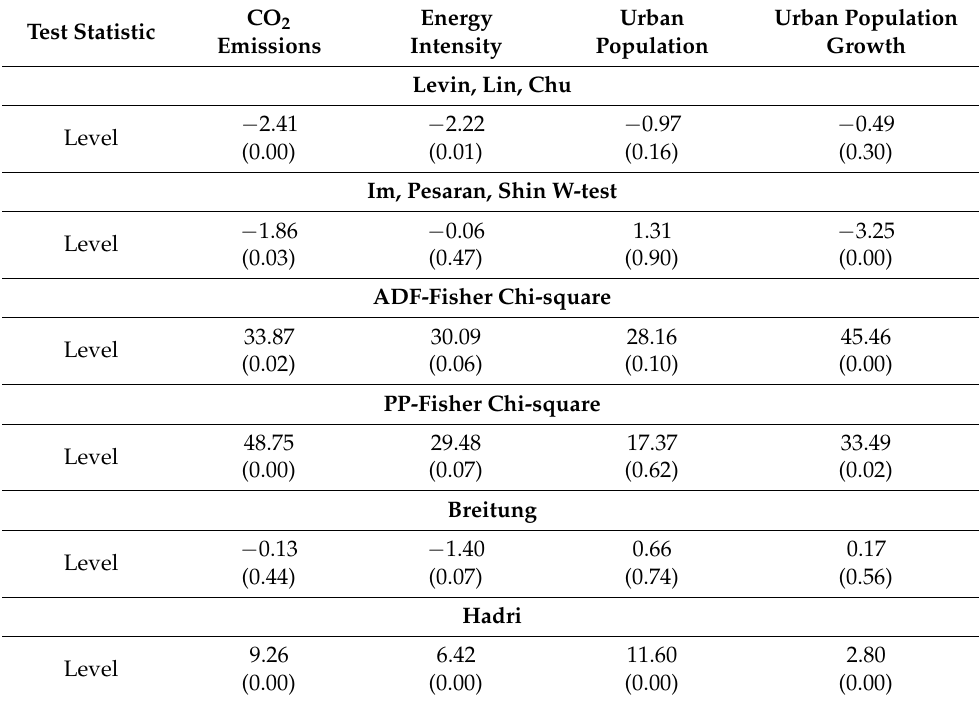
Table 3. Panel unit root tests.